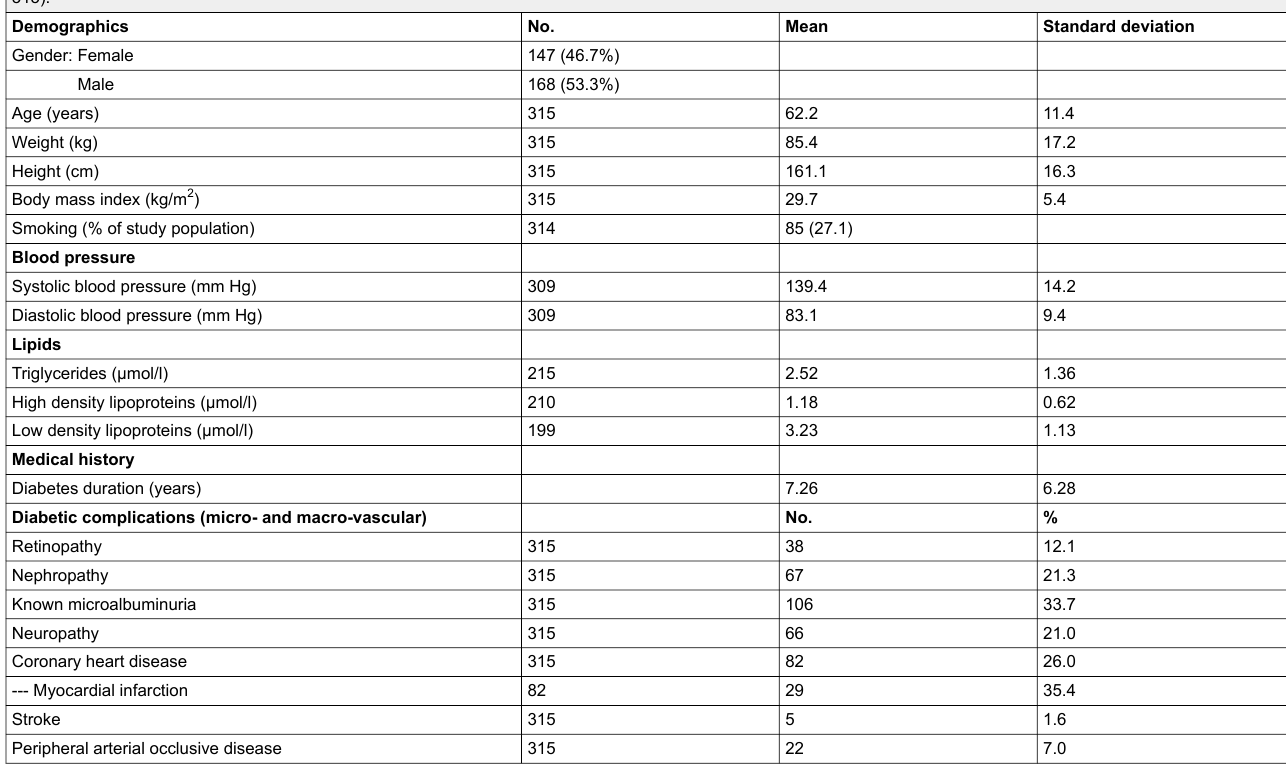
Table 1: Demographics, blood pressure, lipids, medical history (mean ± SD) and diabetic complications (No. and %) at the baseline visit (intention to treat population, n = 315). Demographics